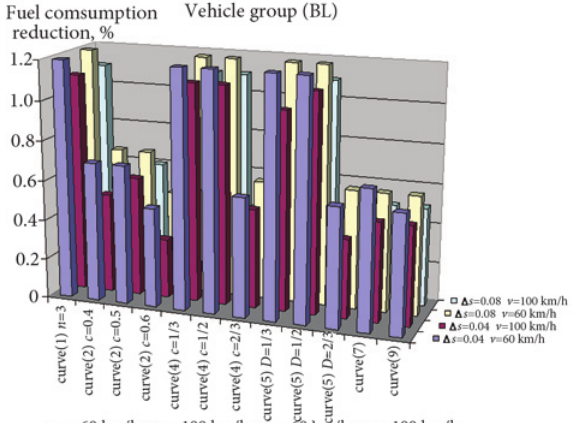
Fig. 13. Fuel consumption reduction in variant B, %, in vehicle group